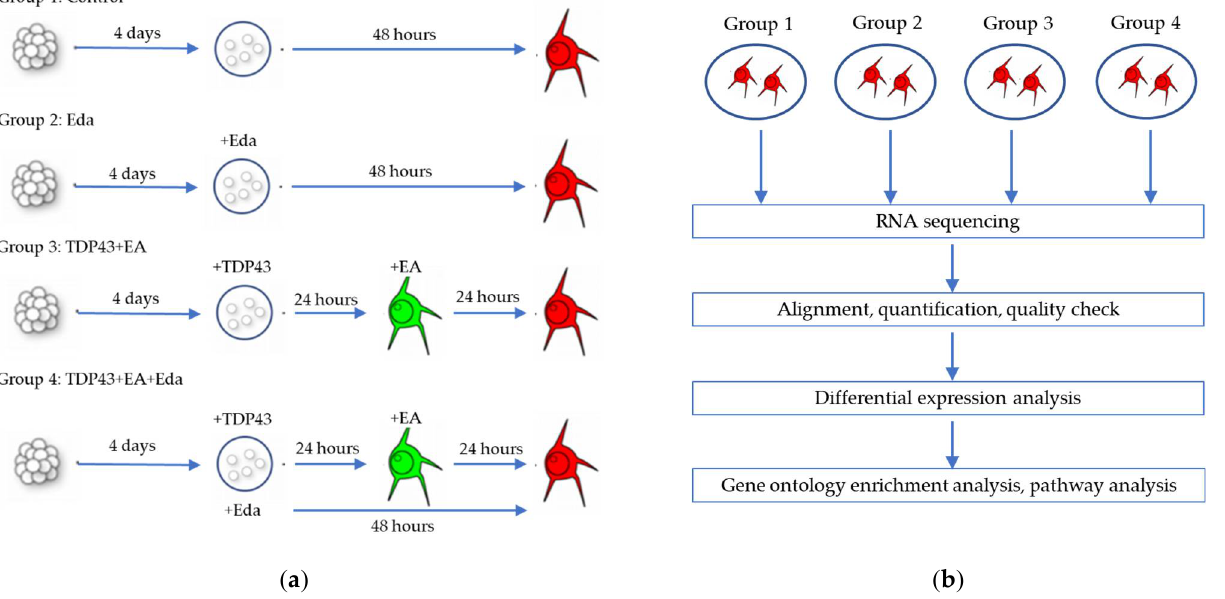
Figure 2. Overview of transcriptome analysis. ( a ) Schematic illustration of experimental design. ( b ) Schematic diagram of RNA sequencing and data analysis (n = 3 in 3 experiments). Eda—Edaravone (50 μmol/L); EA—Ethacrynic acid (20 μmol/L).